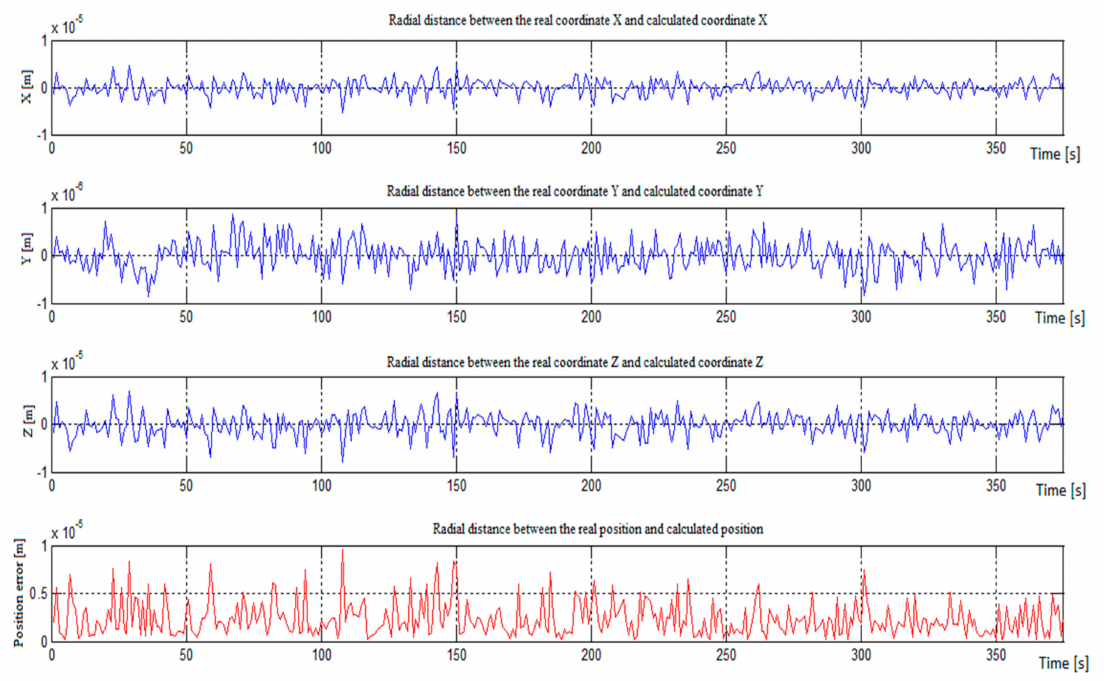
Figure 3. Positioning error in the case of ideal time